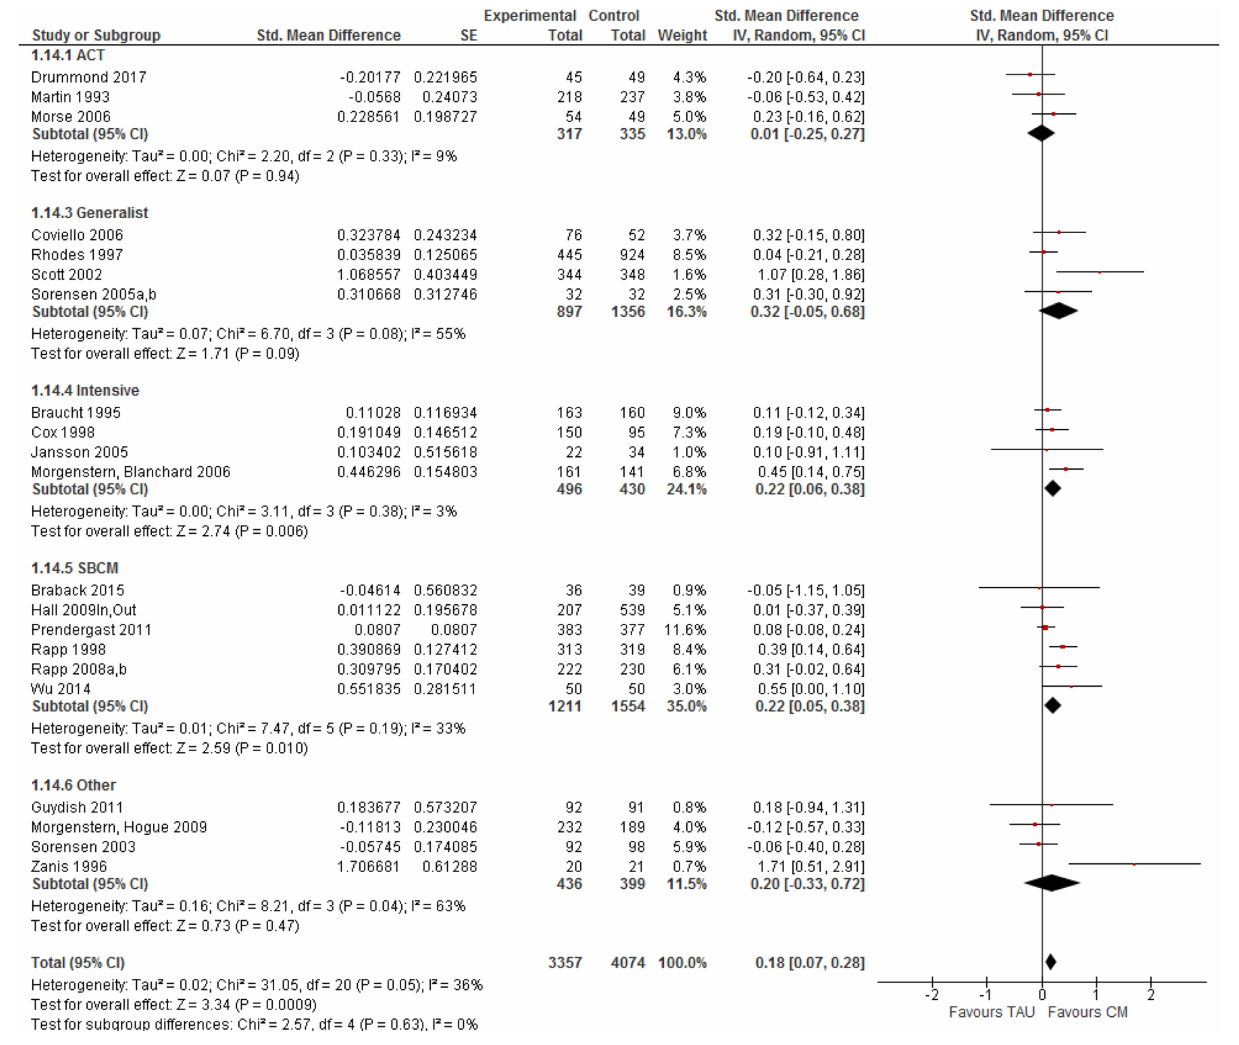
FIGURE 6 | Forest plot of Case management vs. TAU according to CM